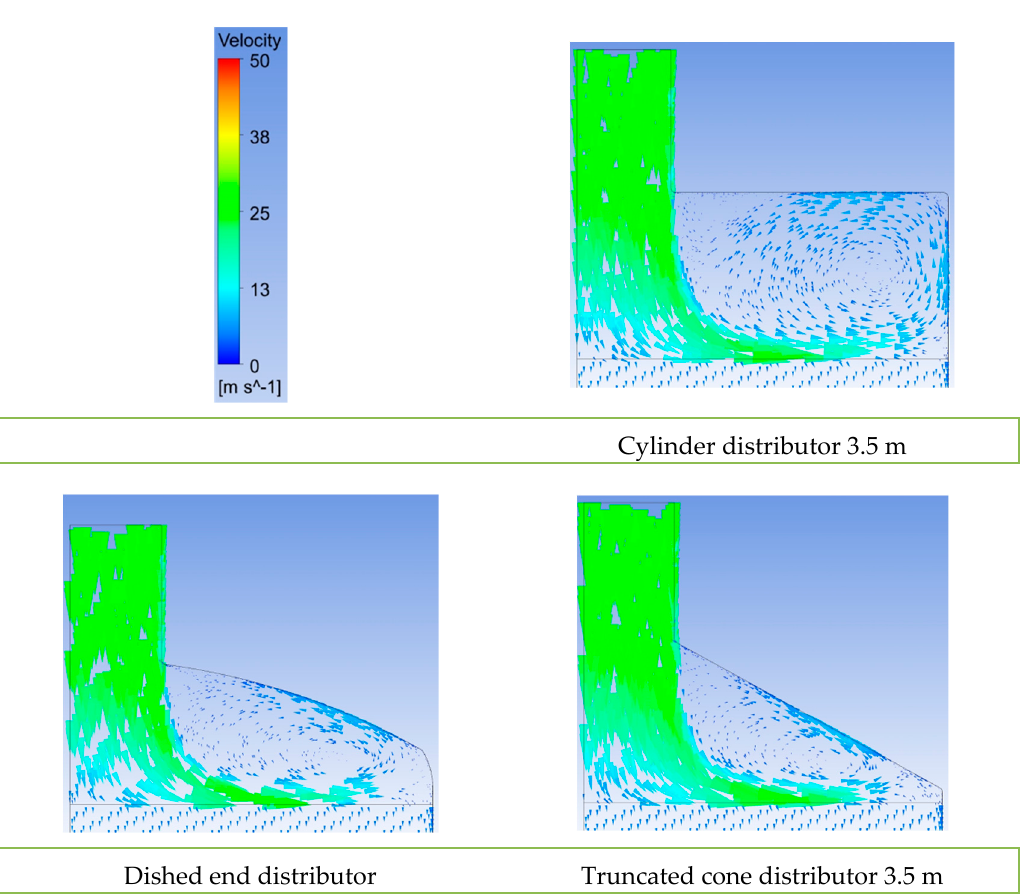
Figure 12. Vector plots of distributor for three different design options for the distributor. Case “Charging, full load”.